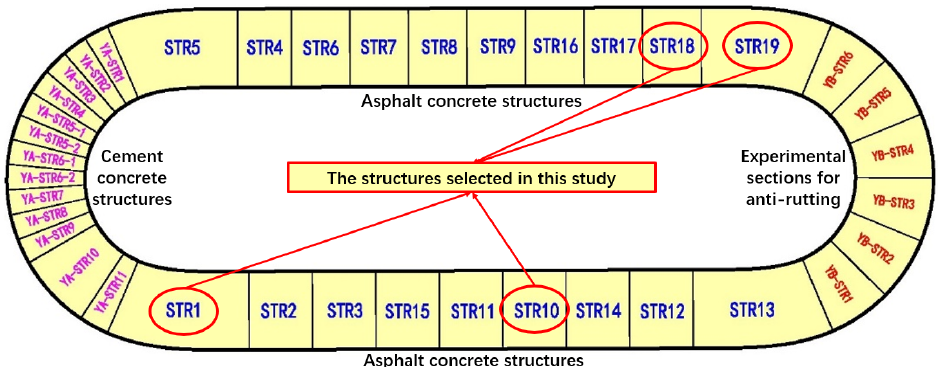
Figure 1. The structures in